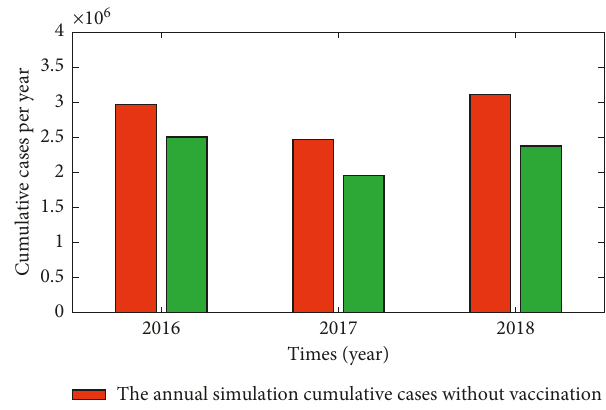
Figure 6: The comparison between the annual simulation cu- mulative cases by system (1) without vaccination ( p � 0) and the annual reported cumulative cases for HFMD in mainland China from 2016 to 2018. The values of other parameters and the initial conditions are the same as in Figure